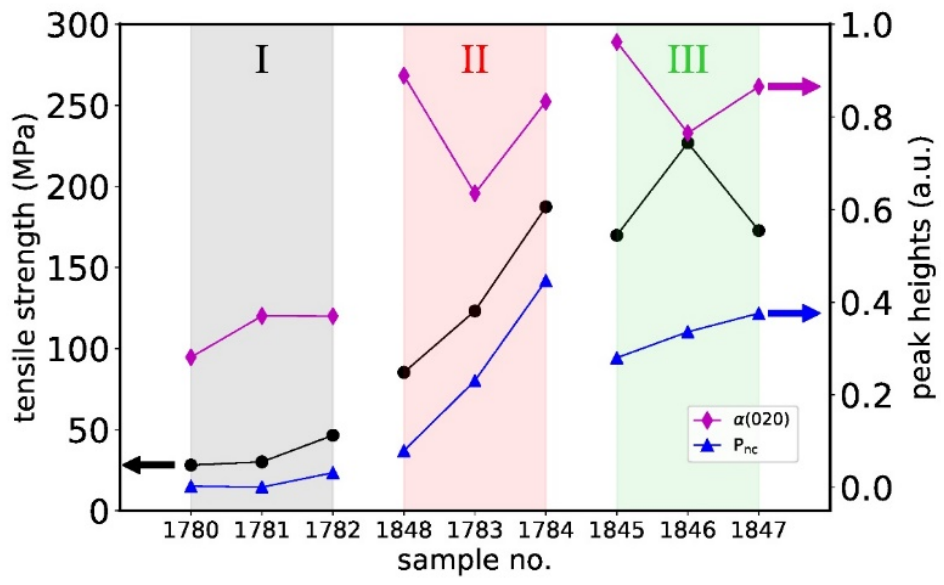
Figure 12. Tensile strength and peak heights of α (020) and P nc reflections in azimuthal profiles as a function of sample number (aged fibers).